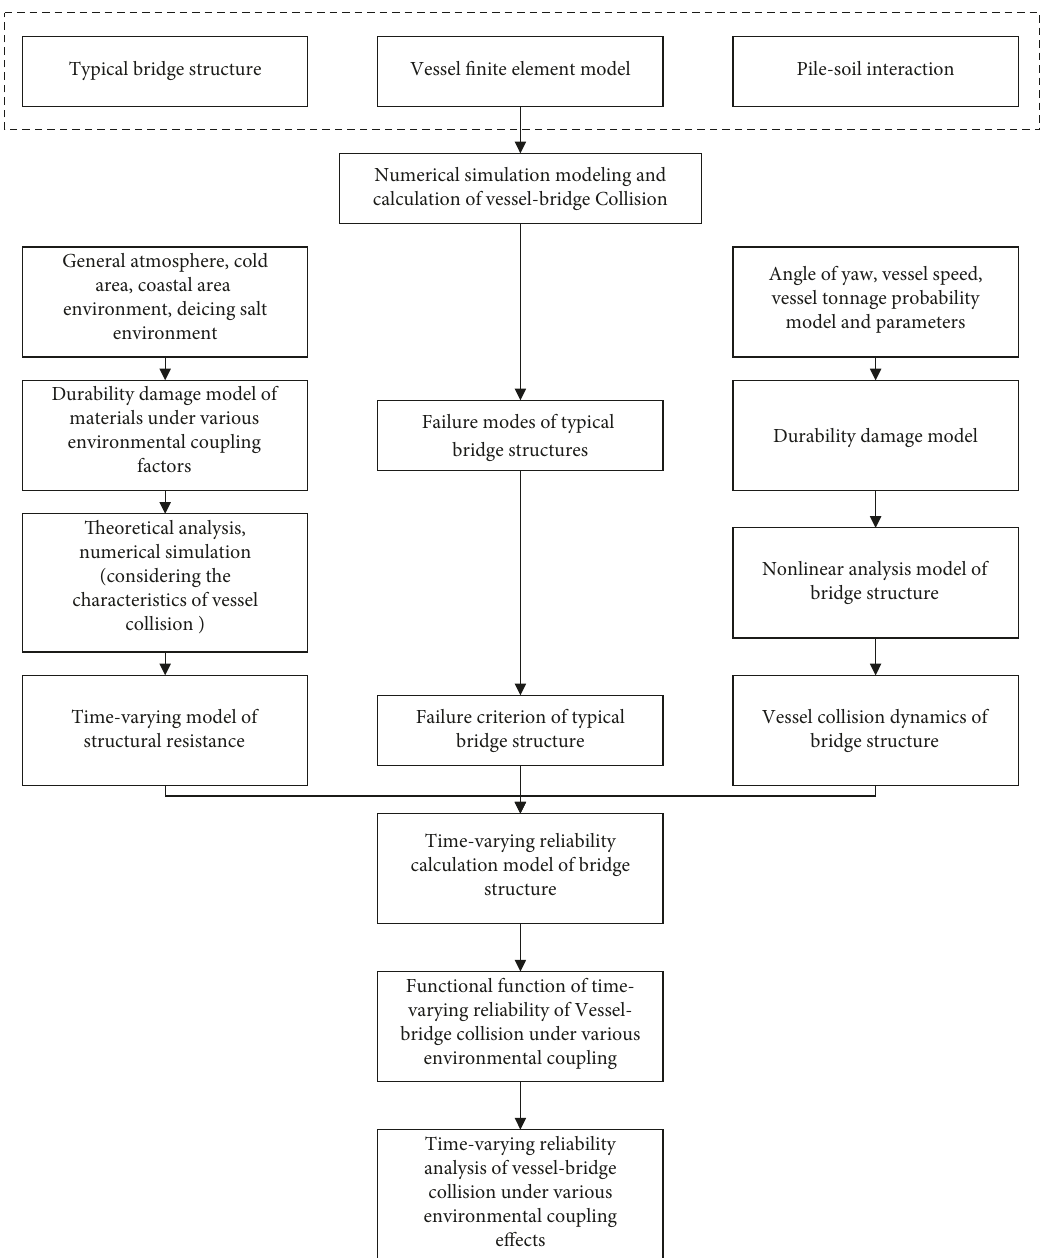
Figure 4: Flow chart of vessel-bridge collision reliability